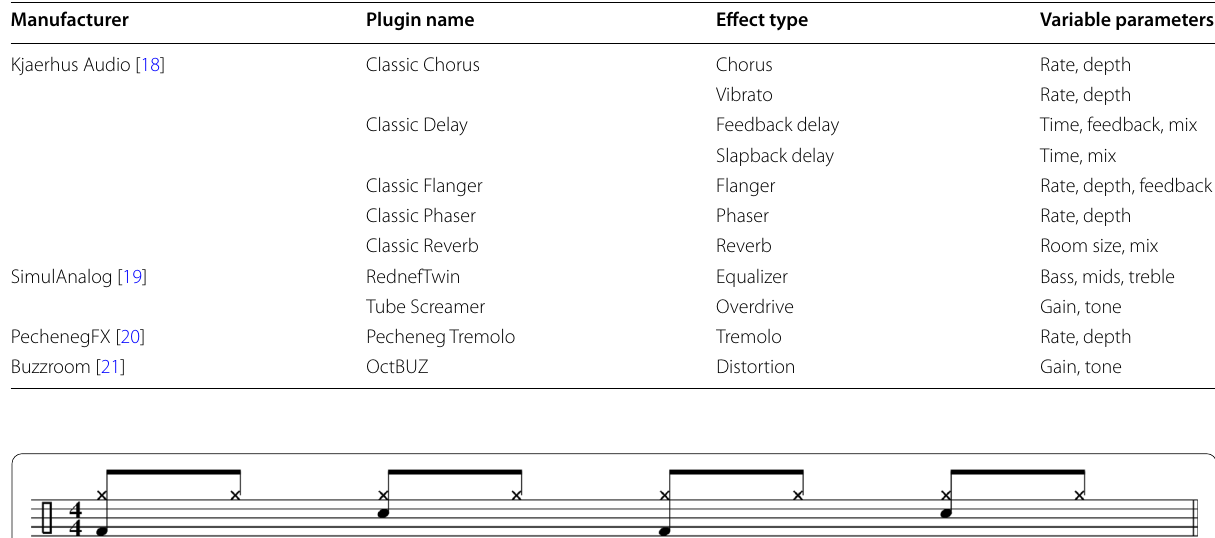
Table 1 Overview of the used guitar effect plugins. The variable parameters are those varied to generate the audio samples of the datasets. To generate the slapback delay effect, the feedback delay with its feedback parameter set to zero was used Manufacturer